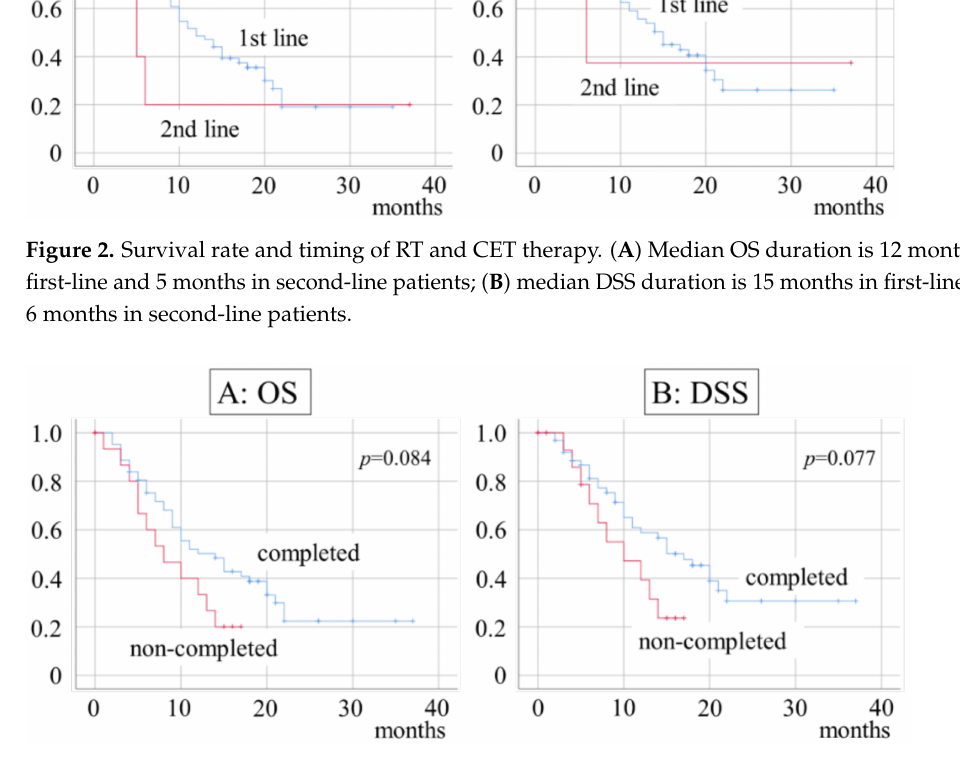
Figure 3. Survival rate and completion of RT and CET therapy. ( A ) Median OS duration is 14 months in completed and 8 months in noncompleted patients; ( B ) median DSS duration is 17 months in completed and 10 months in noncompleted patients.